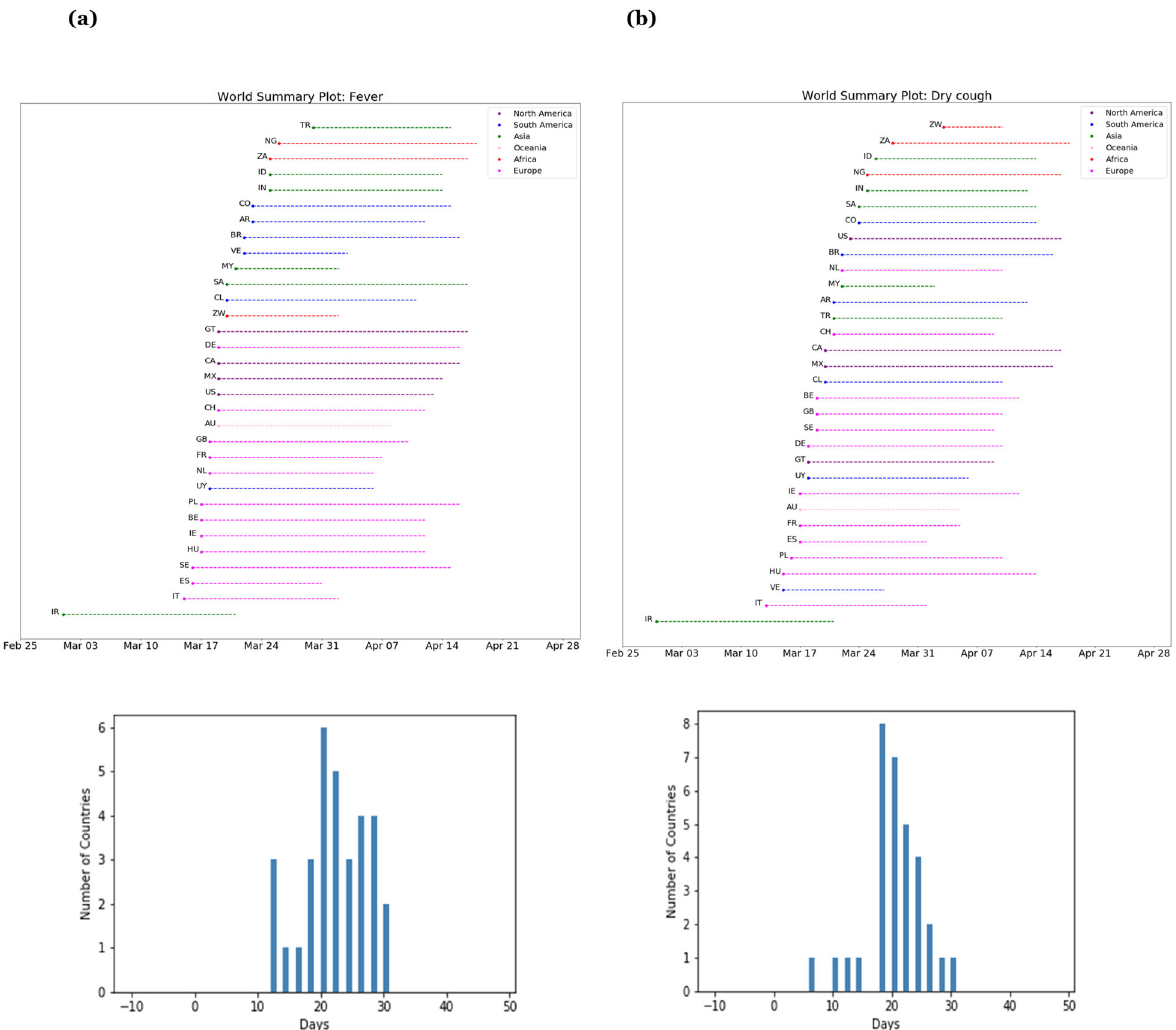
Fig. 2 Search lags in different countries. a Lags between searches for “ fever ” and reported COVID-19 deaths across 32 countries, with a histogram showing the distribution of these lags. Each country is labeled with its ISO Alpha-2 country code. b The same plots shown for searches for “ dry cough ”